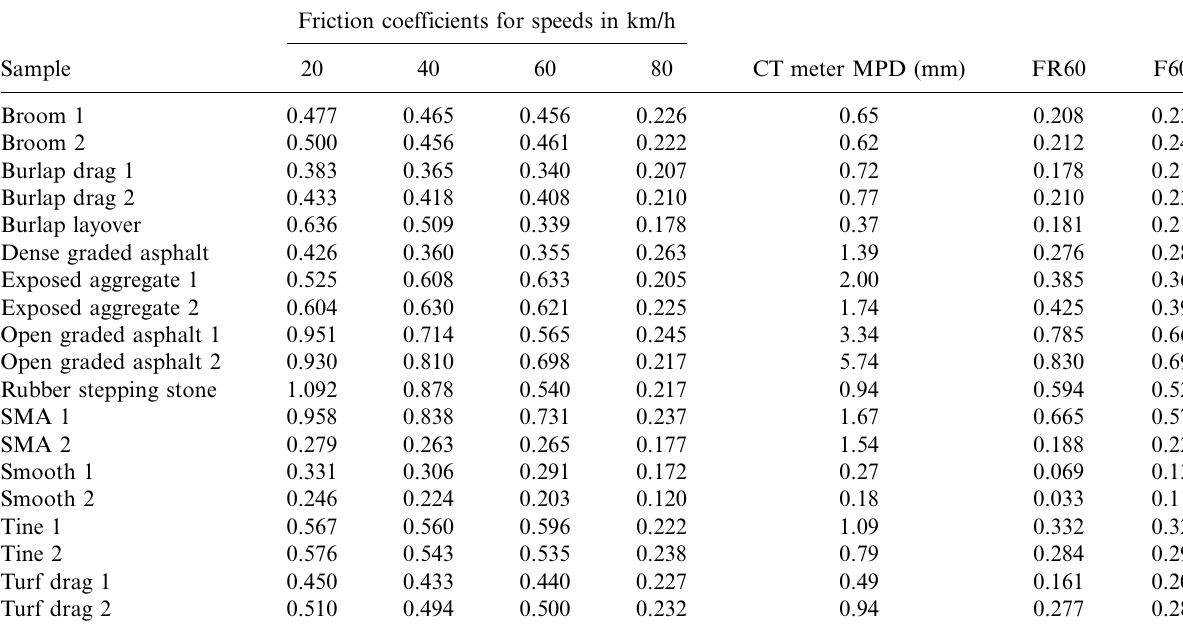
Table 2. Measured friction coefficients as a function of speed and calculated IFI values Friction coefficients for speeds in